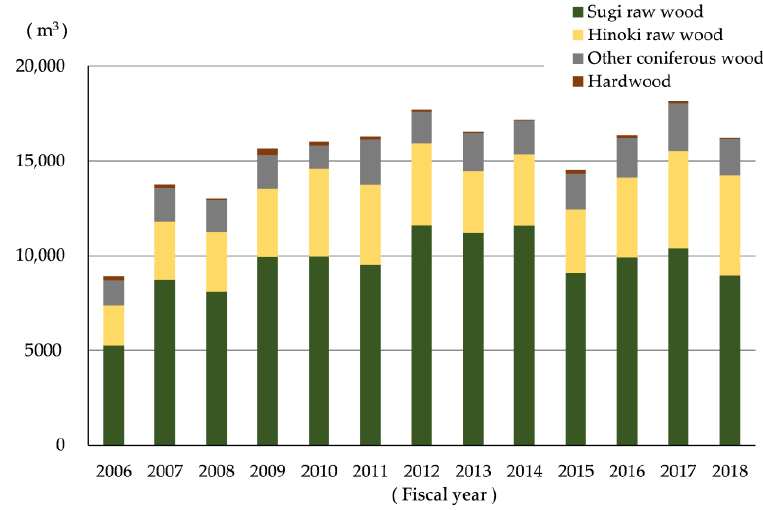
Figure 3. Handling volume of raw wood by tree type at Tama Roundwood Market Center.